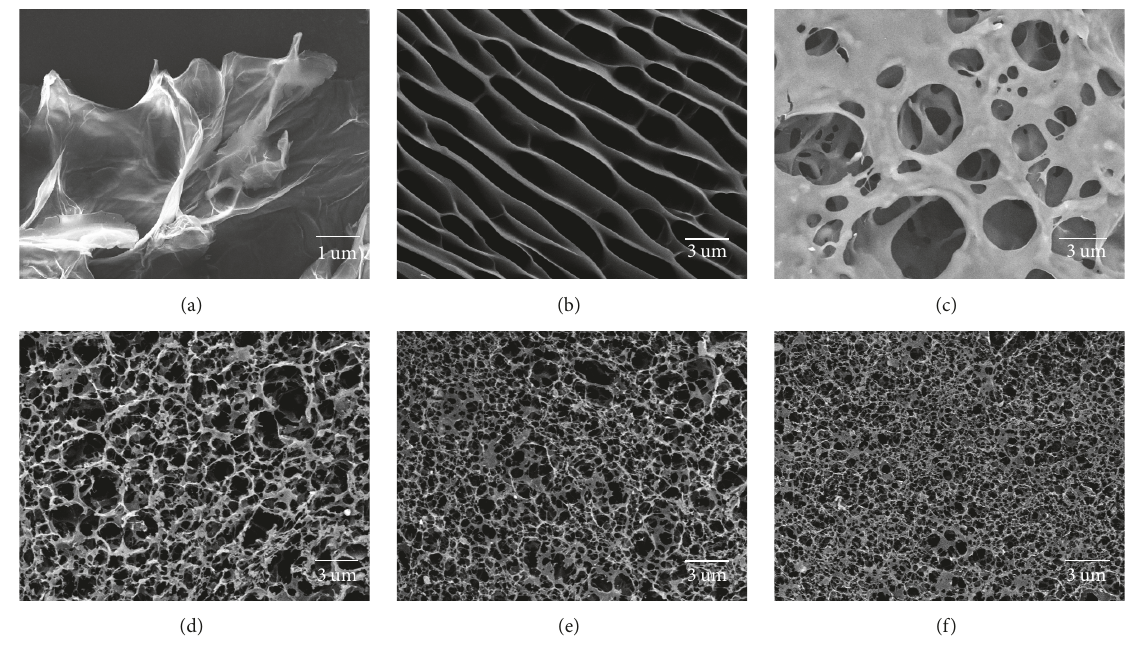
Figure 4: SEM images of GO (a), PNIPAM (b), PNIPAM/KGM (c), PNIPAM/KGM/GO1 (d), PNIPAM/KGM/GO2 (e), and PNIPAM/ KGM/GO3 (f) composite